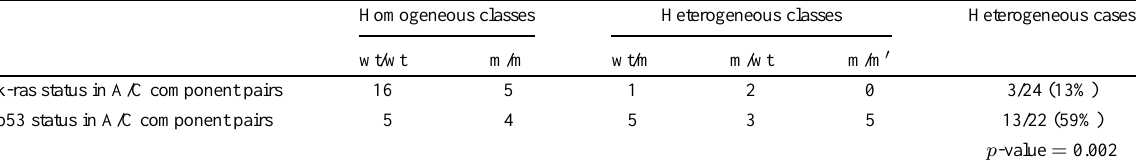
Heterogeneity for k-ras and p53 genetic status between adenomatous (A) and carcinomatous (C) component pairs for human colorectal adeno- mas containing early cancer (A/C) Homogeneous classes